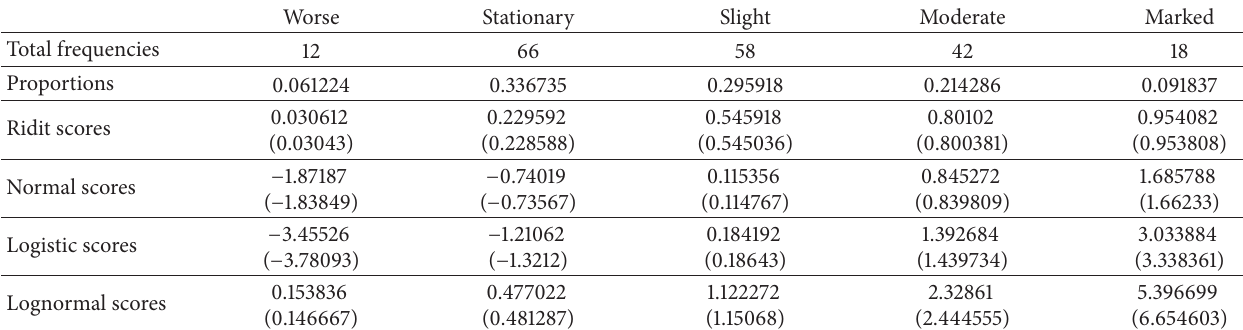
Table 6: Results of using different formulae under the same distribution